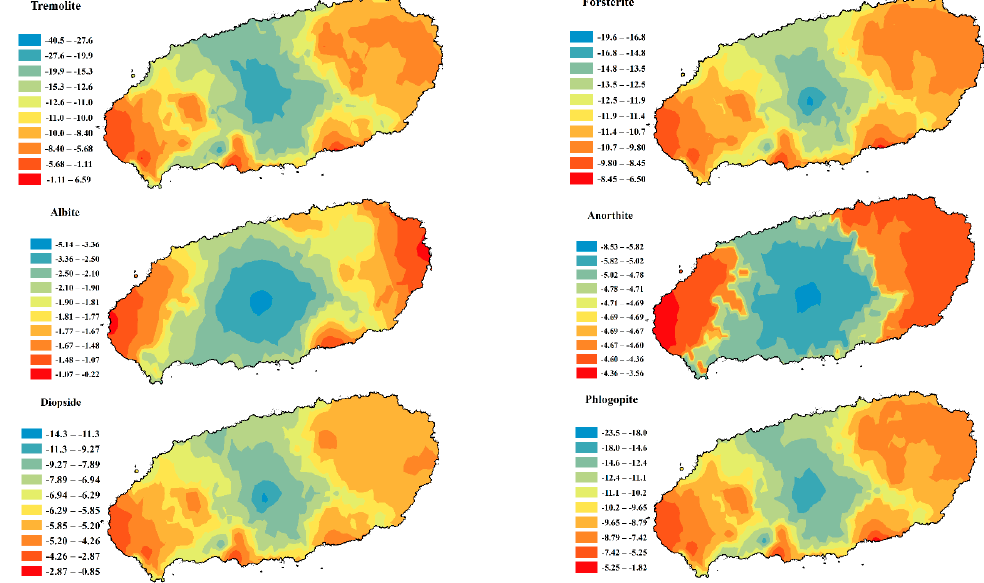
Figure 8. Kriging map of saturation indices between potential reactive minerals and chemical composition of groundwater and spring water samples in Jeju Island. composition of groundwater and spring water samples in Jeju